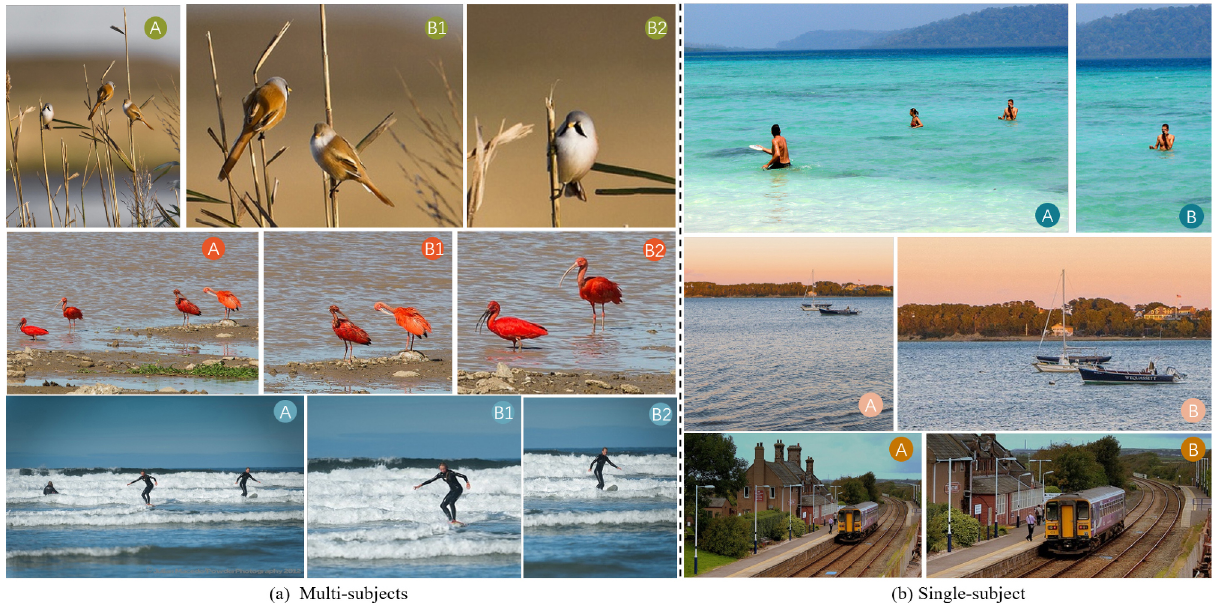
Fig. 2 Subject-aware composition dataset (SACD) examples. (a) Images with multiple subjects. Original images are tagged A, and sub-images labeled by professional artists for different subjects are tagged B1 and B2. (b) Images with a single subject, with tags A and B having the same meaning as in